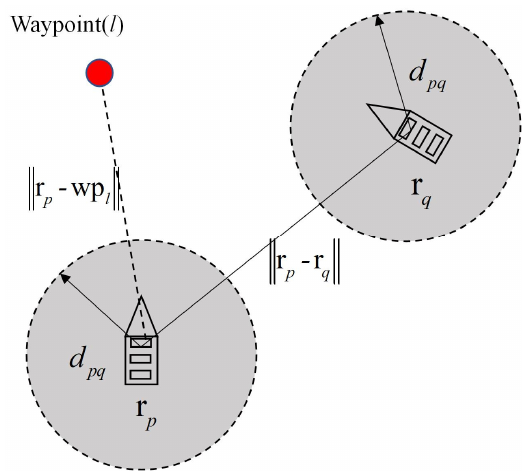
Figure 7. Calculation of the repulsion force between MASS- p and MASS- q .